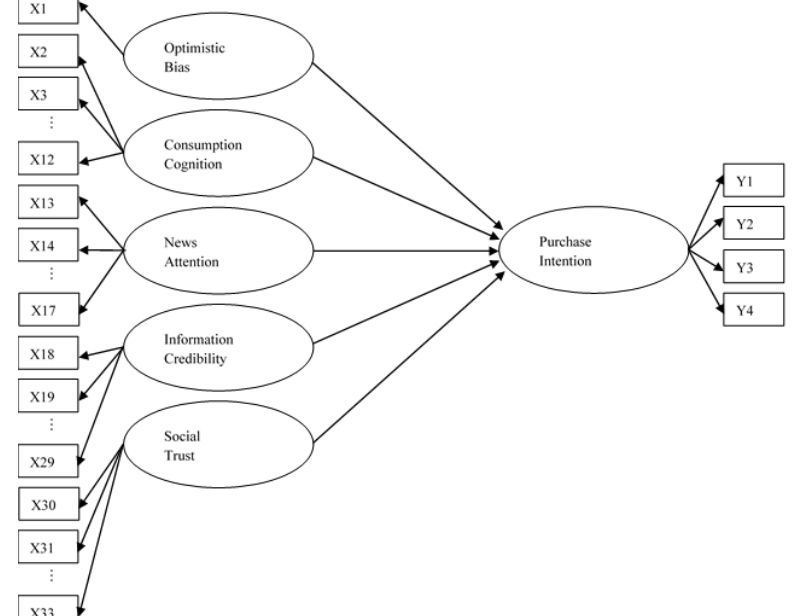
Figure 1. The conceptual model of food safety cognition and consumption attitude. Note: X1 to X33 and Y1 to Y4 refers to the sequential numbers of questionnaire items.